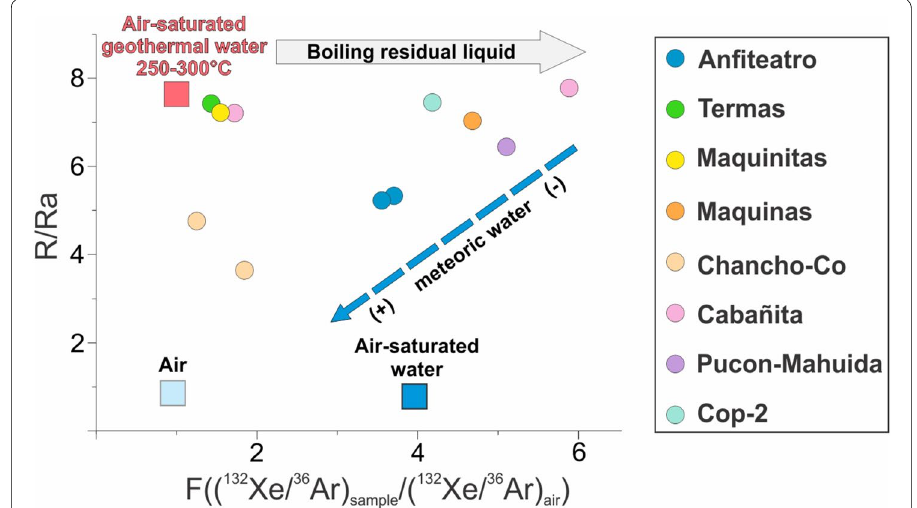
Fig. 8 Boiling and steam separation model based on the isotopic variations of helium and elemental abundance of atmospheric noble gases of the fumaroles at Copahue (modified from Roulleau et al.